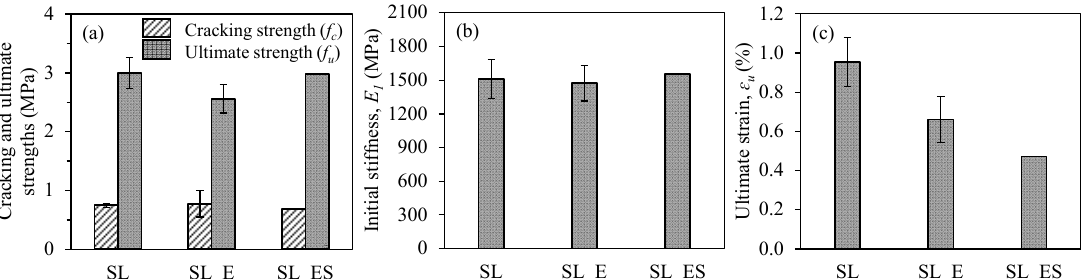
Figure 19. Effect of different surface treatments on the tensile behavior of TRM coupons subjected to sustained load: ( a ) cracking and ultimate strength; ( b ) initial stiffness; ( c ) ultimate strain.